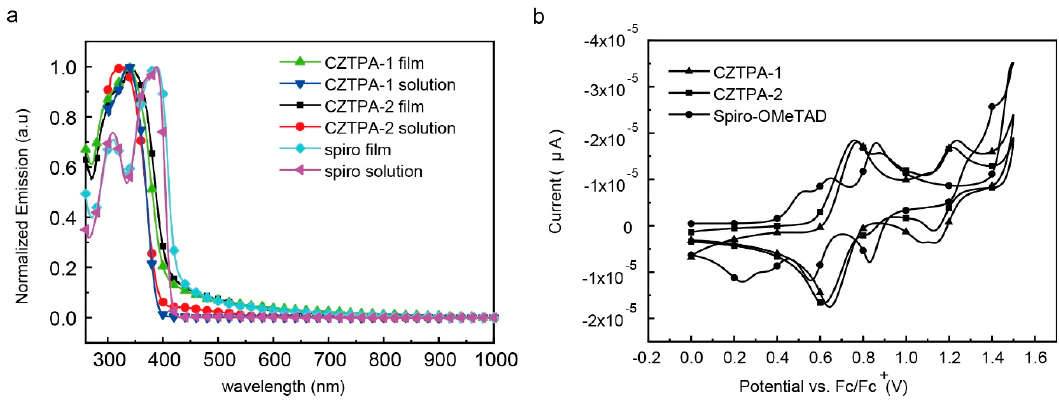
Figure 1. ( a ) Optical absorption spectra of 4,4 ′ -(9-nonyl-9H-carbazole-3,6-diyl)bis ( N , N -bis(4- methoxyphenyl)aniline) (CZTPA-1) and 4,4 ′ -(9-methyl-9H-carbazole-3,6-diyl)bis ( N , N -bis(4- methoxyphenyl)aniline) (CZTPA-2) in chloroform and thin films spin-coated from chloroform. ( b )